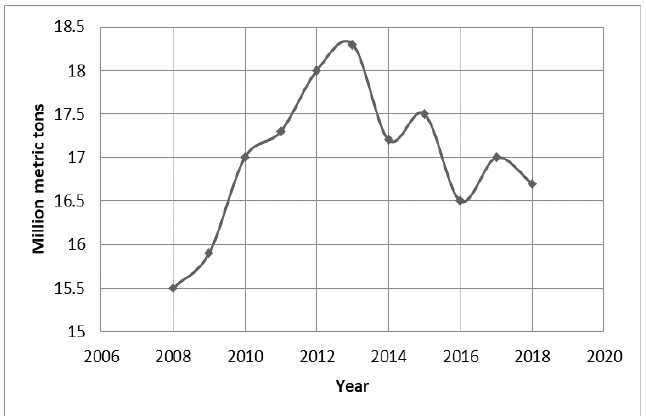
Figure 4. Malaysia palm oil overall exports [23].